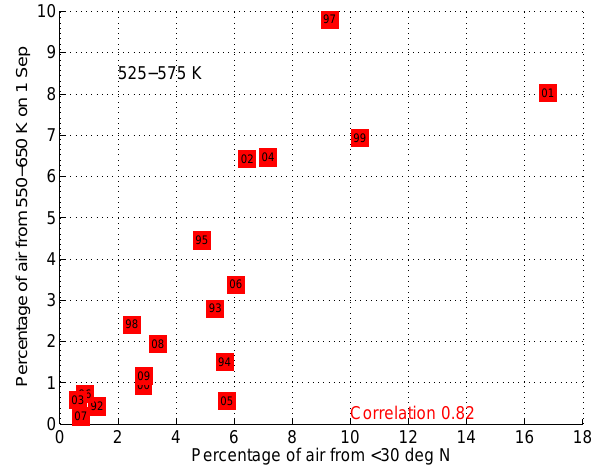
Fig. 12. Schematical illustration of the pathway of air in two years with extreme conditions. Colors show the mean ozone distribution in September. Pathway 1 shows the situation in years with a high fraction of air from low latitudes enclosed in the vortex, which is typically also connected with low net Lagrangian subsidence. Due to the mean ozone distribution, this leads to relatively high ozone values in the vortex. This situation is also typically connected with a strong Brewer-Dobson circulation and a high EP flux through the tropopause. Pathway 2 shows the situation in years with a low frac- tion of air from low latitudes enclosed in the vortex, which is typ- ically connected with high net Lagrangian subsidence, low ozone and a weak Brewer-Dobson